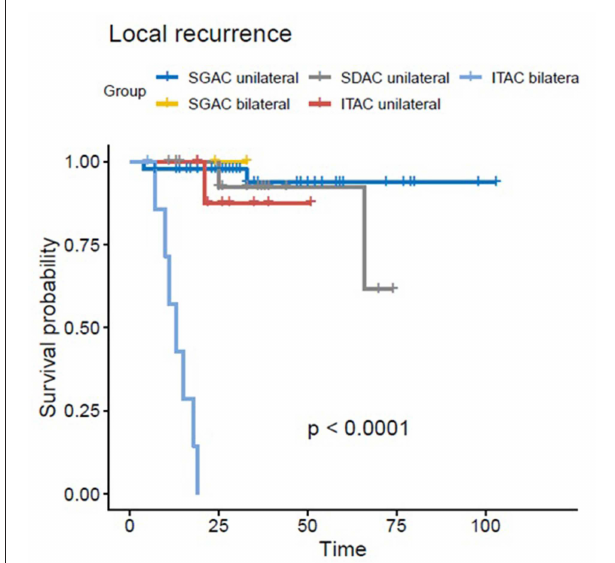
FIGURE 2 | Kaplan-Meier estimates for bilateral vs. unilateral tumor side in dependence of the three groups of SGAC, SDAC, and ITAC with the worst LC for bilateral ITAC ( p <